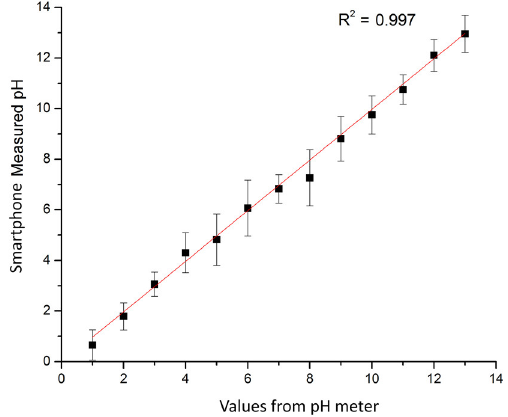
Figure 8. Standard curve of the smartphone processor response to different pH solutions compared to a commercial pH meter. The presented experimental results are averaged from five tests.